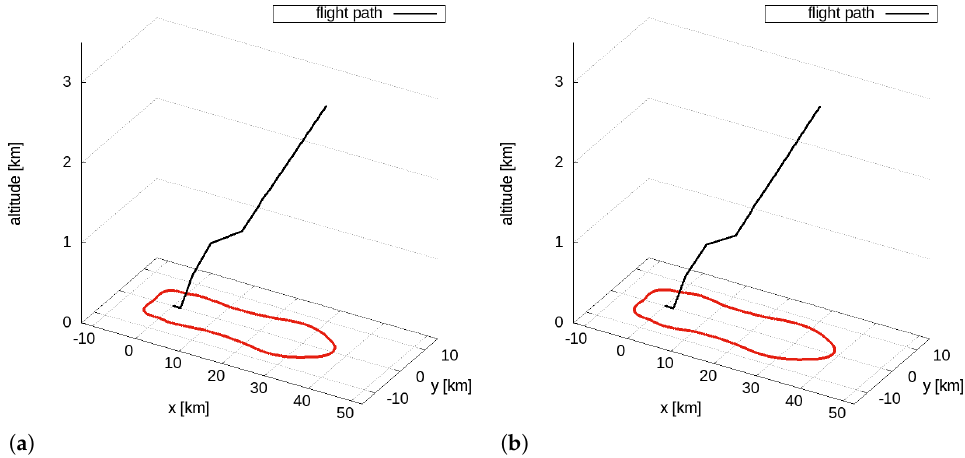
Figure 2. Flight path and 60 dBA isolevel for the reference takeoff manoeuvre. ( a ) single–aisle aircraft and ( b ) twin–aisle aircraft.